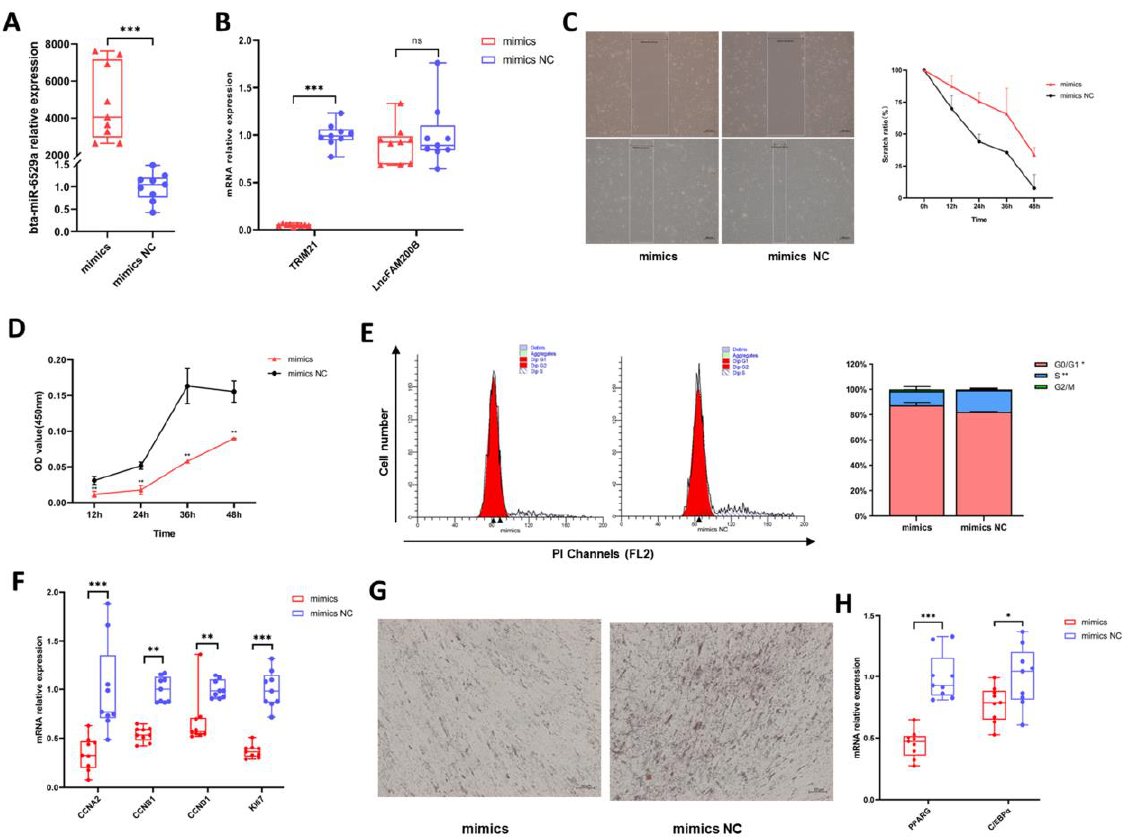
Figure 7. Effects of up-regulation of miR-6529a expression on proliferation and differentiation of preadipocytes. ( A ) Overexpression of miR-6529a. ( B ) The mRNA expression levels of TRIM21 and lncFAM200B after miR-6529a overexpression. ( C ) Scratch test. Only 0 h (top) and 36 h (bottom) results are posted here. The Scratch ratio was obtained by dividing the current scratch width by the initial width. ( D ) CCK-8 results. ( E ) Flow cytometry after miR-6529a overexpression. ( F , H ) are the expression of proliferation marker and differentiation marker after overexpression of miR-6529a, respectively. ( G ) Oil red O staining results. Results are presented as mean ± SD, * p < 0.05. ** p < 0.01. *** p < 0.001.